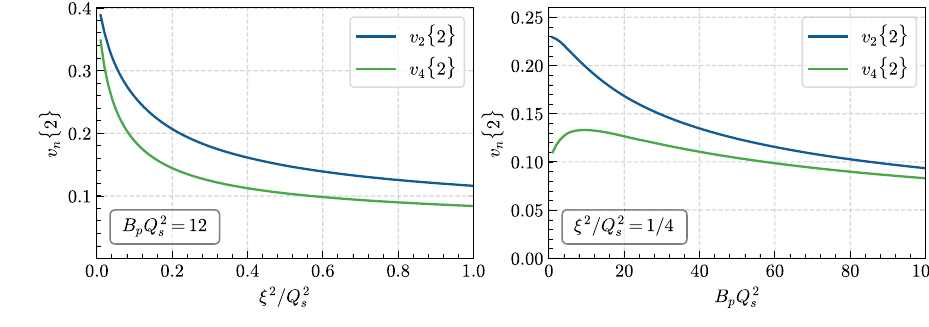
Fig. 4 Dependence of the even 2-particle azimuthal harmonics, v { 2 } , on α ≡ ξ 2 / Q 2 2 n s (left, for B p Q 2 s = 12) and n D ≡ B p Q 2 s (right, for ξ 2 / Q 2 s = 1 /